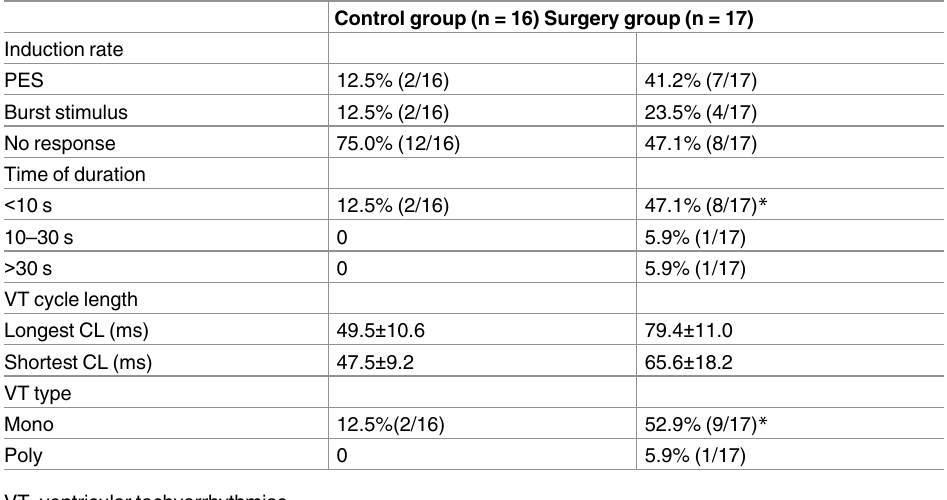
Table 2. Incidence of VT induced by PES or burst